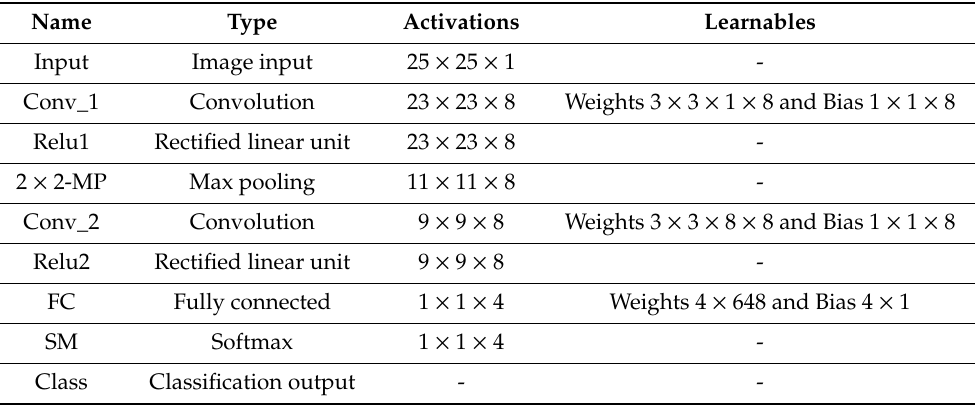
Figure 13. ( a ) Resulting convolutional neural network (CNN) architecture; and ( b ) accuracy results for different convolutional layers, pooling layers, and convolutional filters. Table 1. CNN configuration.